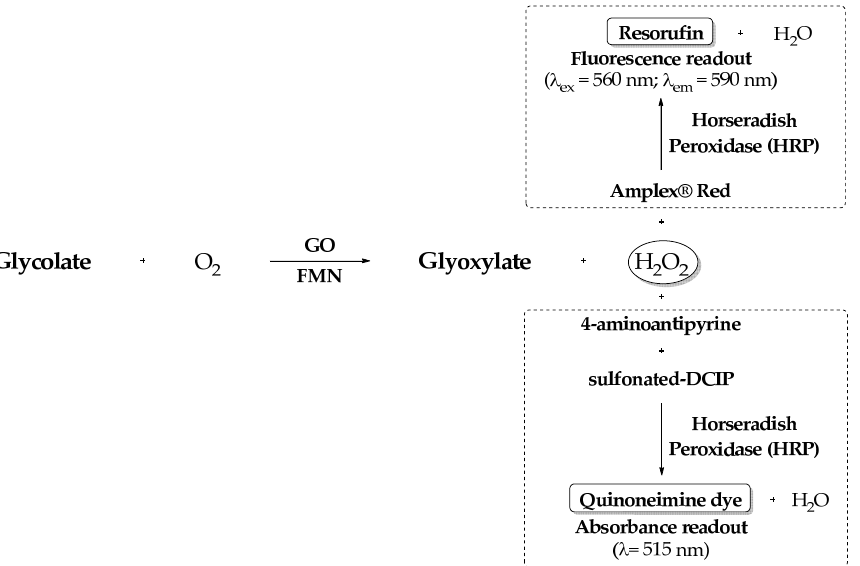
Figure 8. Colorimetric and fluorometric enzymatic assays for the evaluation of glycolate oxidase inhibitors (GOi´s).